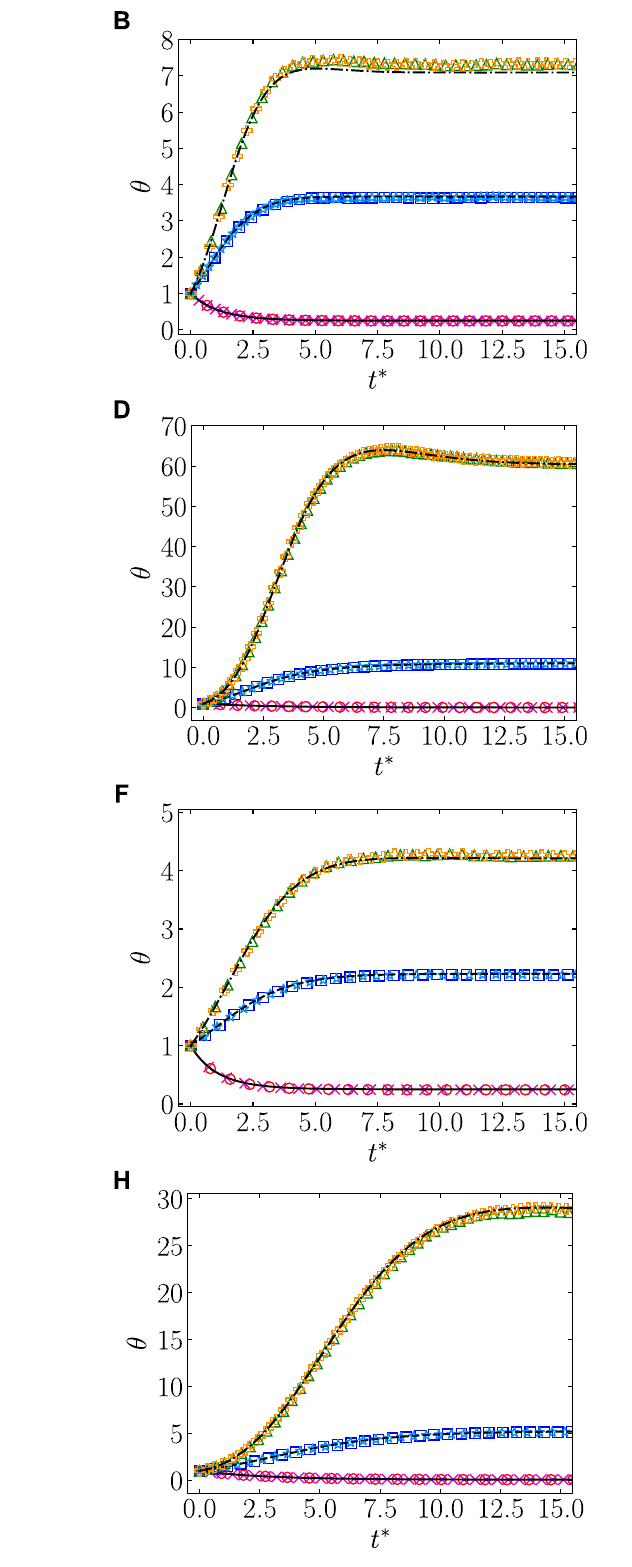
FIGURE 6 Timeevolutionofthereducedmeantemperature T *andtherotational-to-translationaltemperatureratio θ for ε =0,0.8,and1.Theinitialconditions are T 0 * (cid:1) 1 . 5and θ 0 =1inallthecases.Thevaluesofthecoef fi cientsofrestitutionare (A,B) :( α , β )=(0.7,0); (C,D) :( α , β )=(0.7, − 0.7); (E,F) :( α , β )=(0.9,0);and (G,H) : ( α , β ) = (0.9, − 0.7). Lines correspond to the theoretical prediction from Eq. 30, and symbols refer to DSMC and EDMD simulation